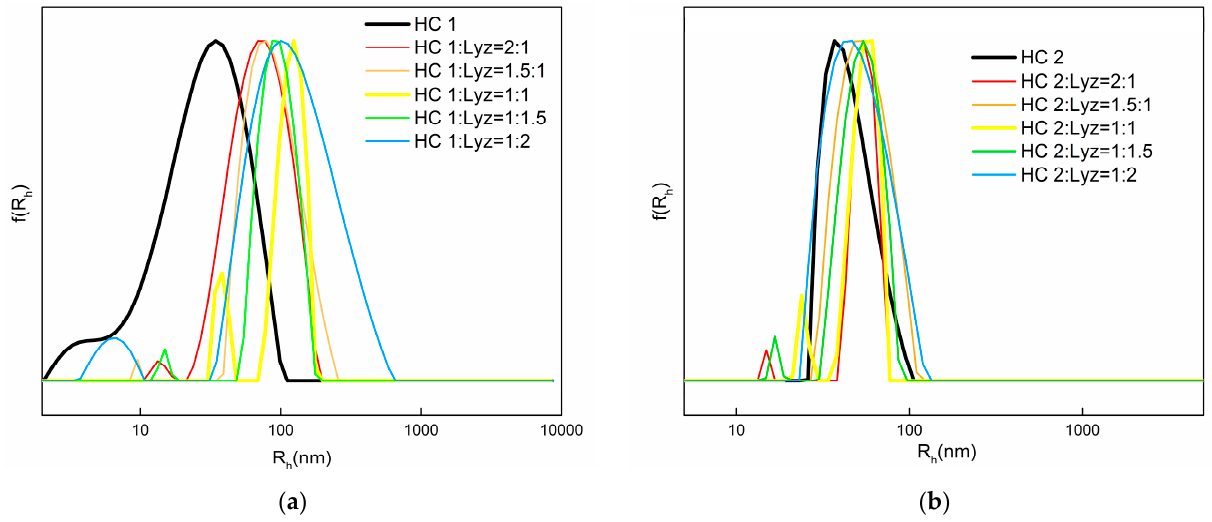
Figure 6. Size distributions of the HC–Lyz complexes formed from HC 1 ( a ) and HC 2 ( b ) copolymers. Either way, both HC 1 and HC 2 present pH-dependent self-assembly. MAA is Table 3. DLS and ELS results for HC–Lyz complexes. an anionic polyelectrolyte, with a pK a value of around 4.8. The ionization degree of